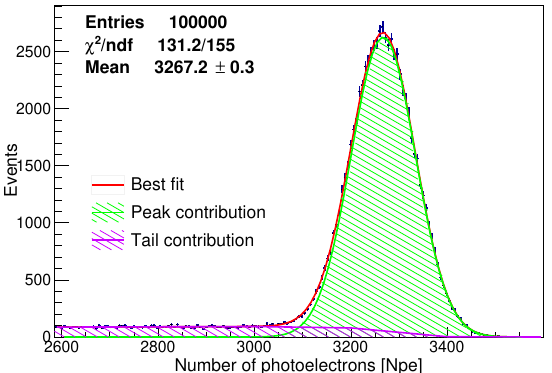
Figure 6 . The PE distribution of 60 Co source at the center of JUNO. Contributions from the fully absorbed events and energy loss tail are indicated in the figure.